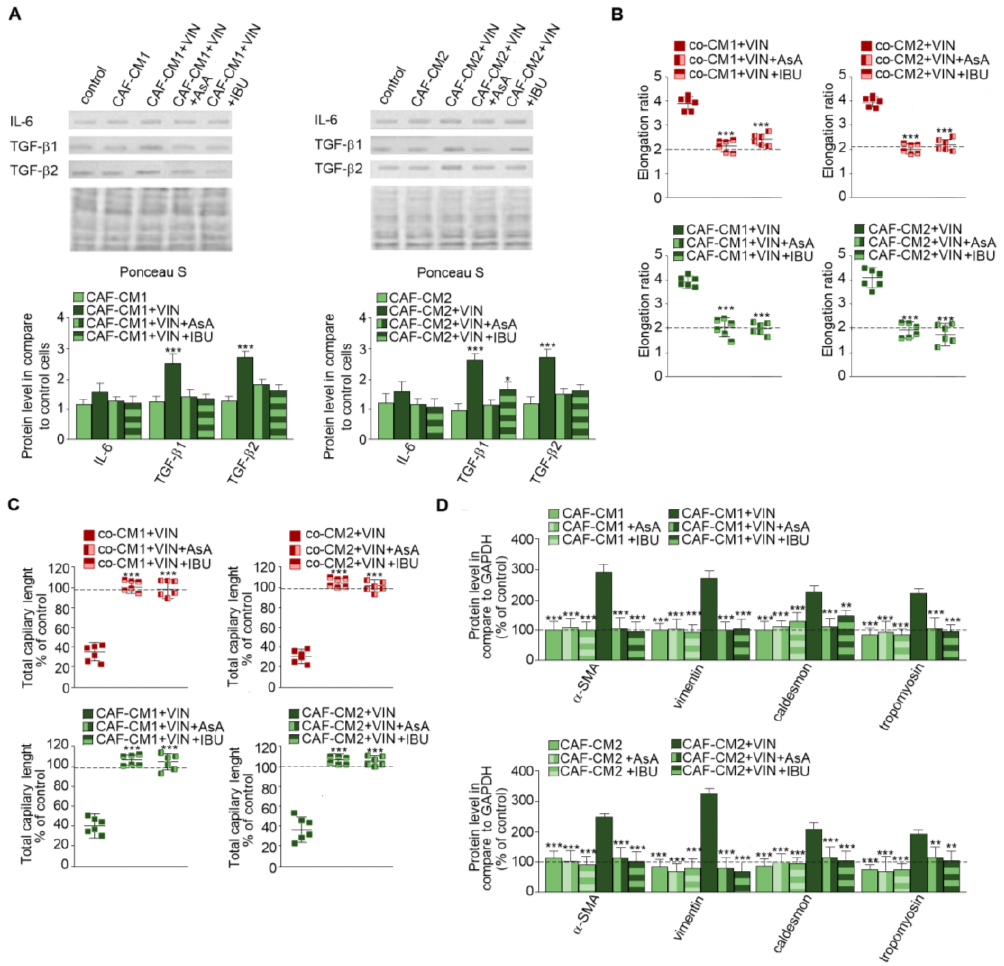
Figure 5. NSAIDs inhibit the e ff ect of vincristine-induced EndMT stimulation. Level of TGF- β s (TGF- β 1 and TGF- β 2) and IL-6 in CM isolated from coculture of CAF-like cells and colon cancer or CAF-like cells maintained in colon cancer cell CM treated, if necessary, with vincristine ( A ) were studied by Western blot. The results are provided as means ± SD ( n = 3); * p < 0.05, *** p < 0.005. The blots are representative of three independent experiments. As the control of loading, the Ponceau Staining was shown. Then, HMEC-1 cells were cultured in medium supplemented with CM isolated from coculture of CAF-like cells and colon cancer or CAF-like cells maintained in colon cancer cell CM and treated, if necessary, with vincristine ( + VIN) or NSAIDs (IBU or AsA). Then, elongation ratio ( n = 6) ( B ), capillary assay ( n = 9) ( C ), and level of contraction protein (caldesmon, tropomyosin), vimentin, and α -SMA were analyzed by Western blot ( D ), with GAPDH used as the loading control. The results are provided as means ± SD ( n = 3), ** p < 0.001, *** p < 0.005. The blots are representative of three independent experiments. The values from control cells are marked by dashed lines.